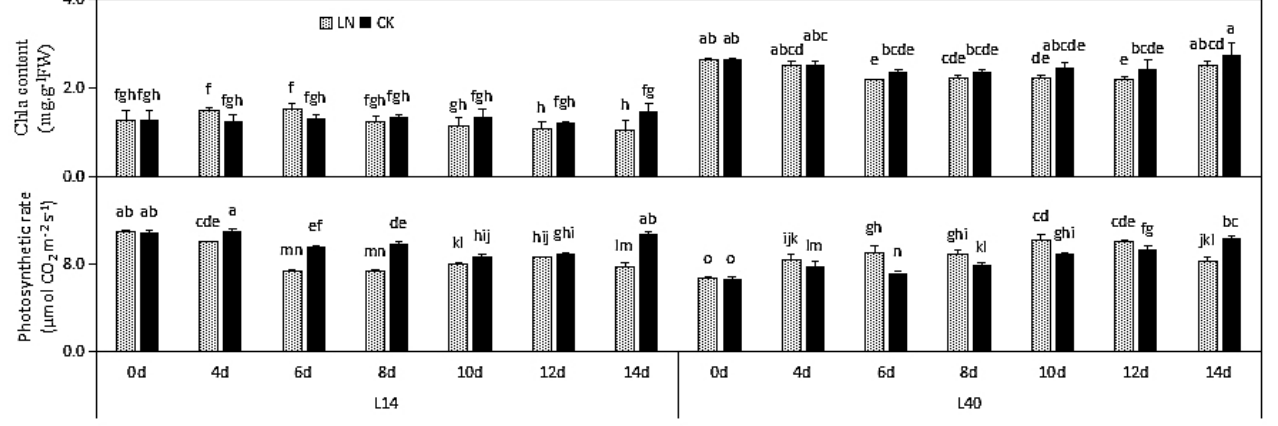
Figure 5. Effects of LN treatment on Chl content and net Pn of Chinese cabbage genotypes L14 and L40. Values shown are means ± SE; n = 6 (two experiments and three replications of each genotype). Means with different letters are significantly different according to the Duncan test at p < 0.05. Chl content and net Pn changes under LN stress compared to CK content are indicated on the bars. The letters “LN” and “CK” indicate whether the N content was low or normal.